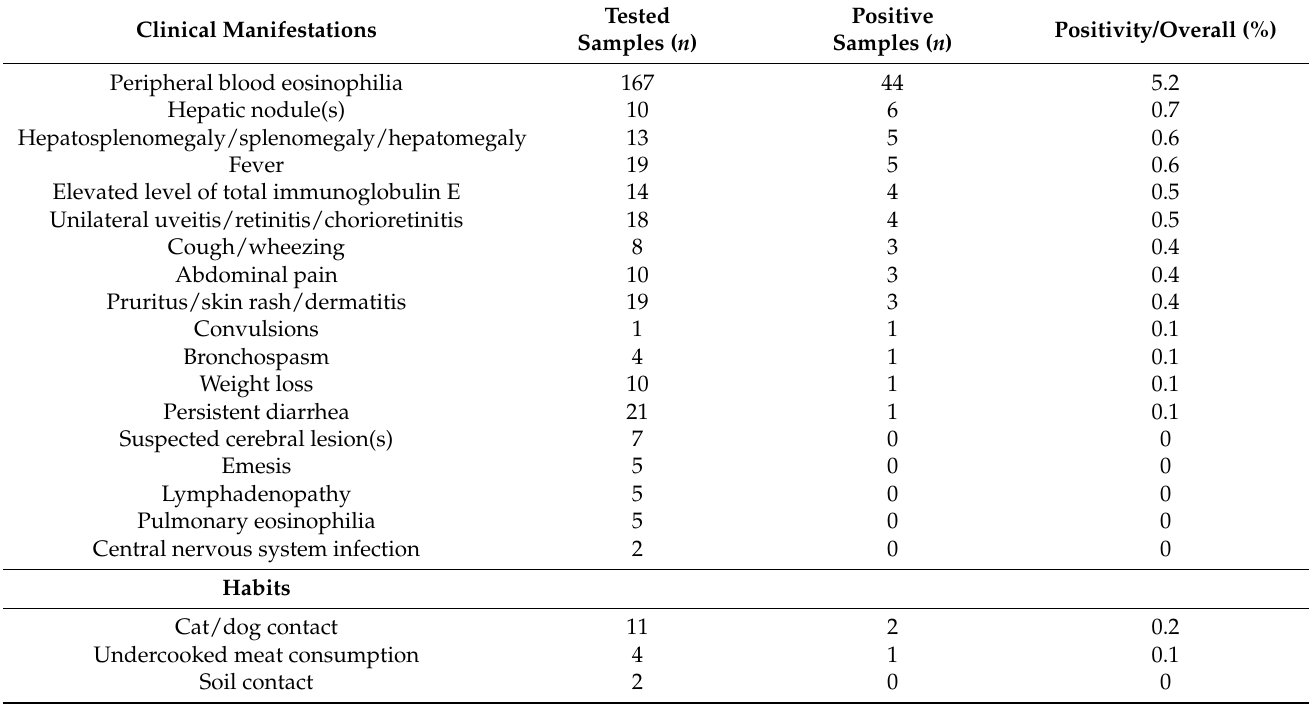
Table 2. Clinical manifestations were referred by the clinicians according to the tested samples and positive samples for Toxocara spp. Positivity shows the percentage of cases with clinical manifestation over the 846 samples